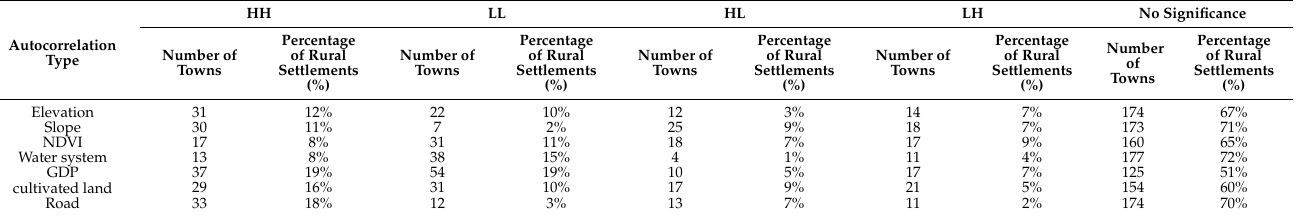
Table 4. Spatial autocorrelation between the level of sustainable development and the influencing factors in the Miaoling Mountain villages and the number of townships.